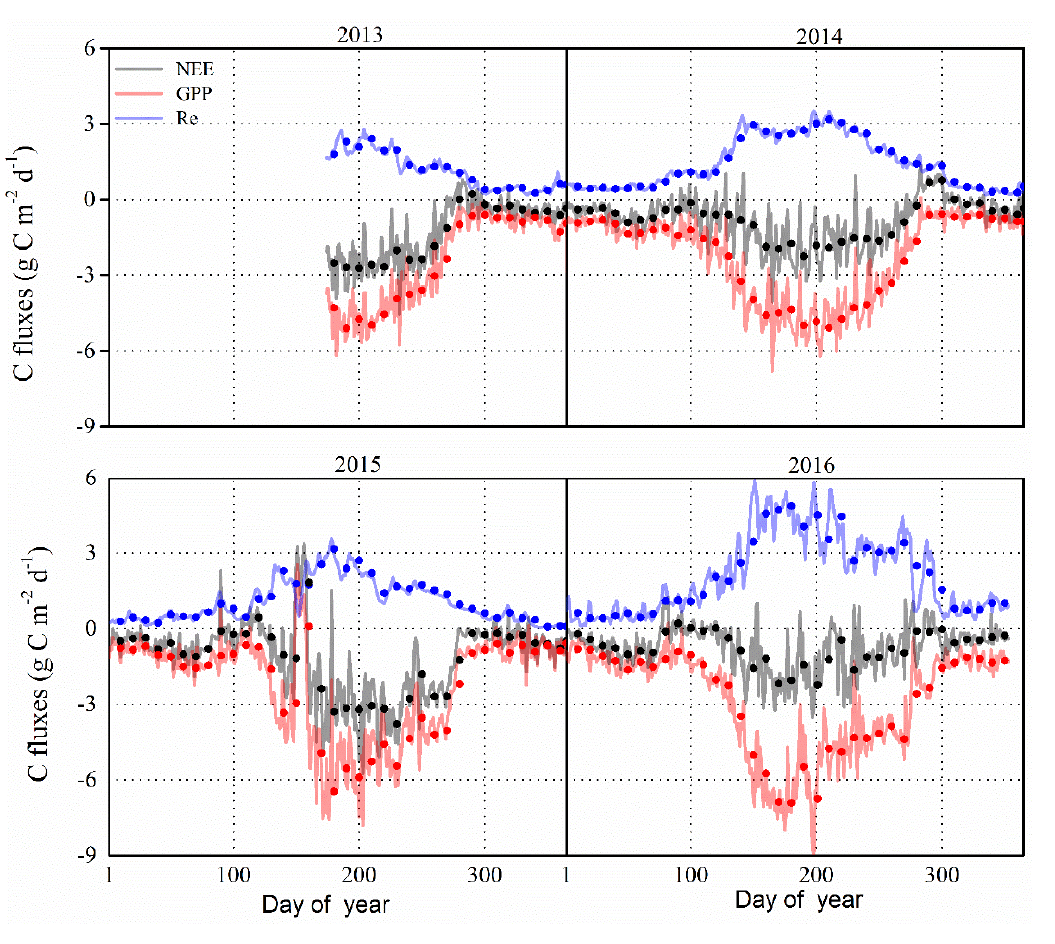
Figure 5. Seasonal and inter-annual variations of net ecosystem exchange (NEE), gross primary production (GPP) and ecosystem respiration (Re) in 2013–2016 at the study site. Solid lines represent the variations of daily carbon fluxes, and dots represent the ten-day means.